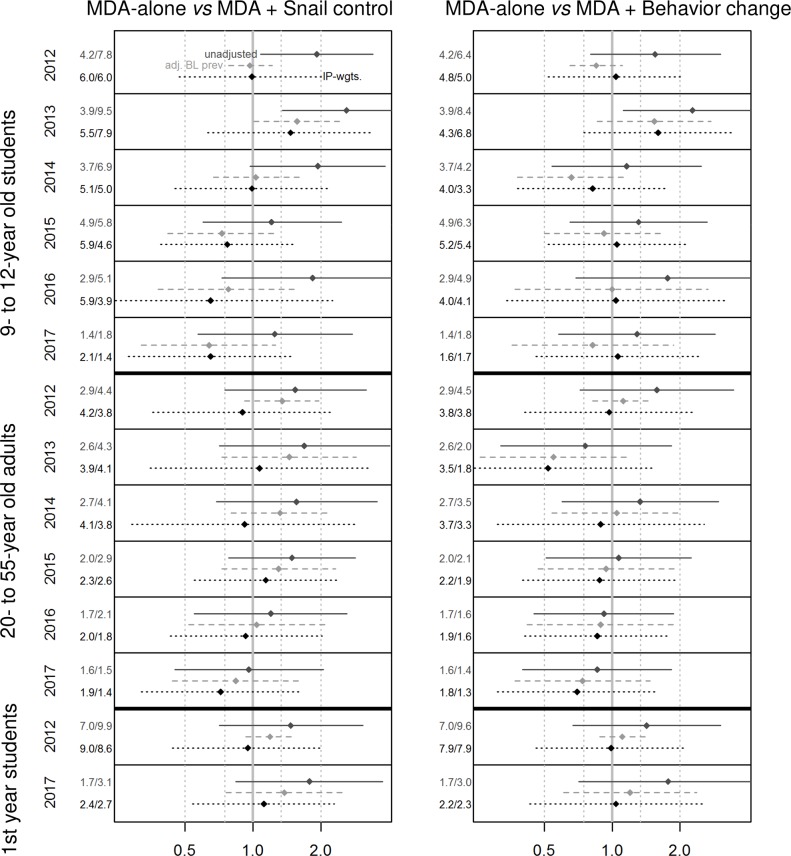
Odds ratios (OR) of S. haematobium infection.Data are unadjusted OR and weighted OR adjusted for baseline prevalence imbalance (inverse probability weights) and cluster size with 95% confidence intervals of the three participant groups in all study years. Treatment arms are biannual mass drug administration (MDA) plus snail control (arm 2) or biannual MDA plus behavior change (arm 3) versus biannual MDA-only (arm 1). Numbers represent the prevalence or the weighted prevalence, respectively, in a certain year (left: arm 1, right arm 2 or 3, respectively).